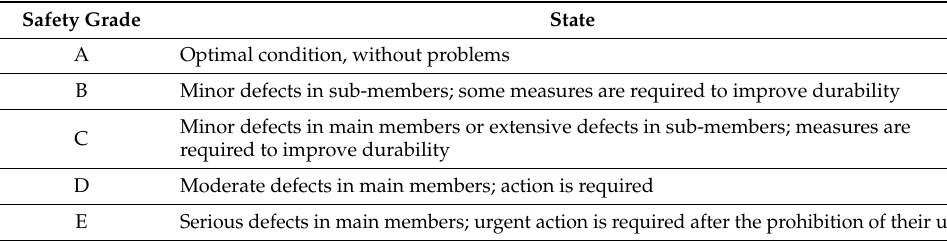
Table 2. Score organization by risk factor.